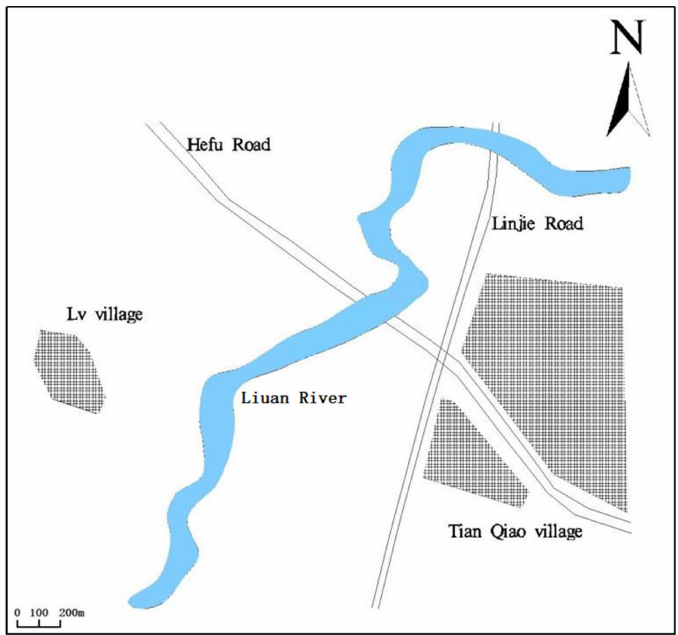
Figure 3. Location map of the main Liuan River.